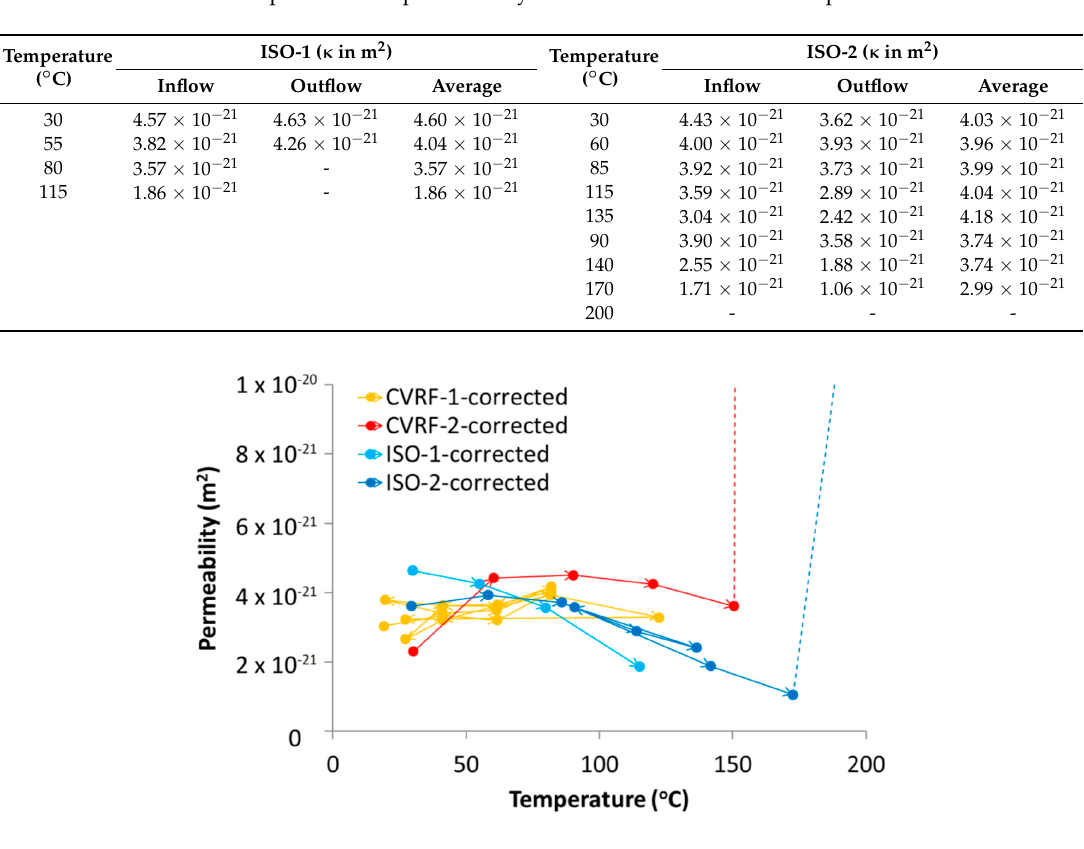
Figure 11. Intrinsic permeability from the four tests (CVRF-1, CVRF-2, ISO-1, ISO-2) corrected for water viscosity and density changes with temperature (Figure 3B,C). CVRF-1 and CVRF-2 data represent outflow permeabilities. The first two ISO-1 points represent outflow data whilst the second two points represent inflow data. The ISO-2 permeabilities derive from the difference between backpressure outflow and average confining flow-rate over the same timeframe.